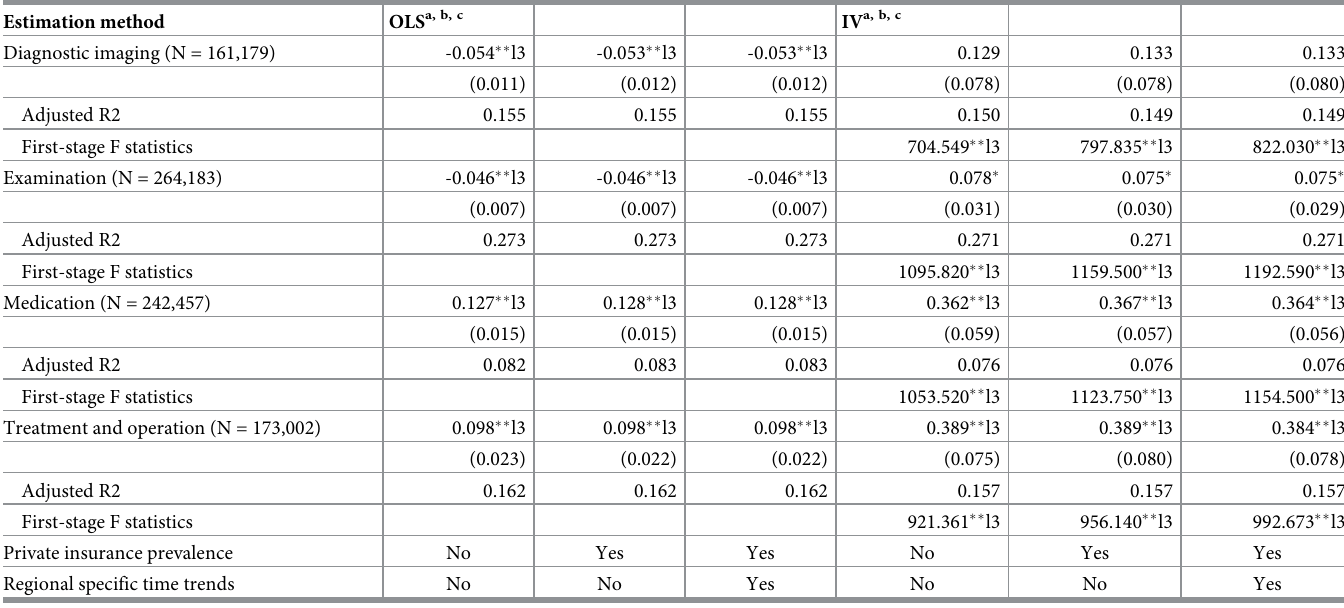
Table 4. Estimated arc elasticities by treatment type.